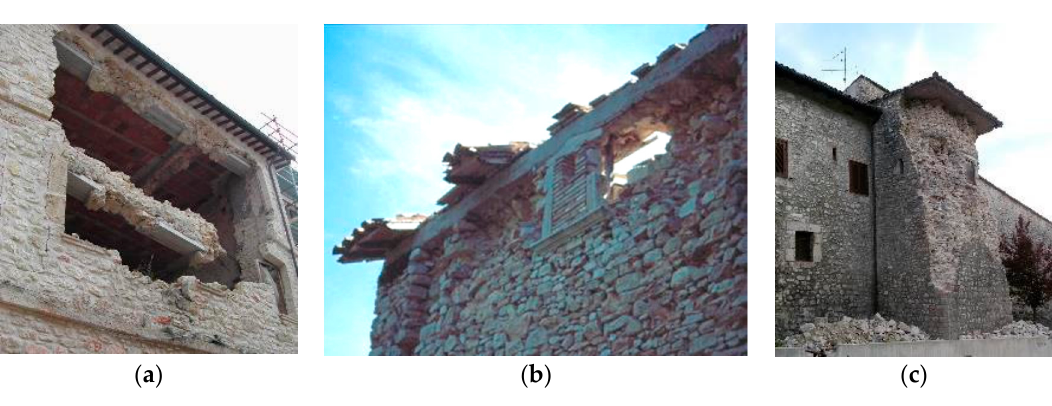
Figure 4. Example of damaged load bearing masonry walls due to the hammering of: ( a ) r.c. tie beam at floors level; and ( b , c ) at roof level.